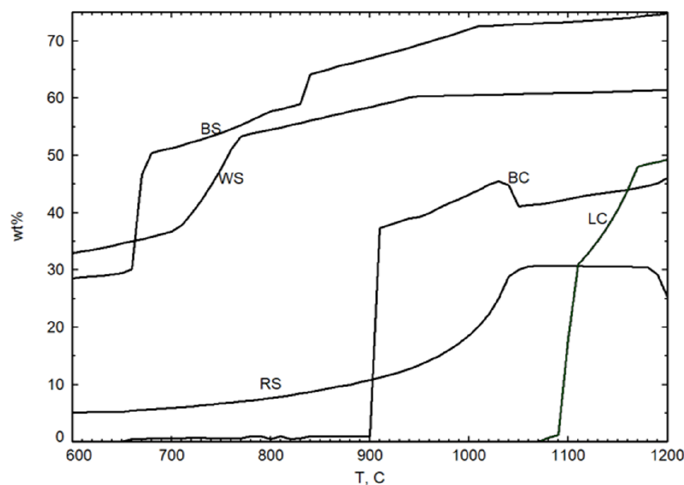
Figure 10. Phases of slag in equilibrium for rye straw (RS), wheat straw (WS), barley straw (BS), lignite (LC), and bituminous coal